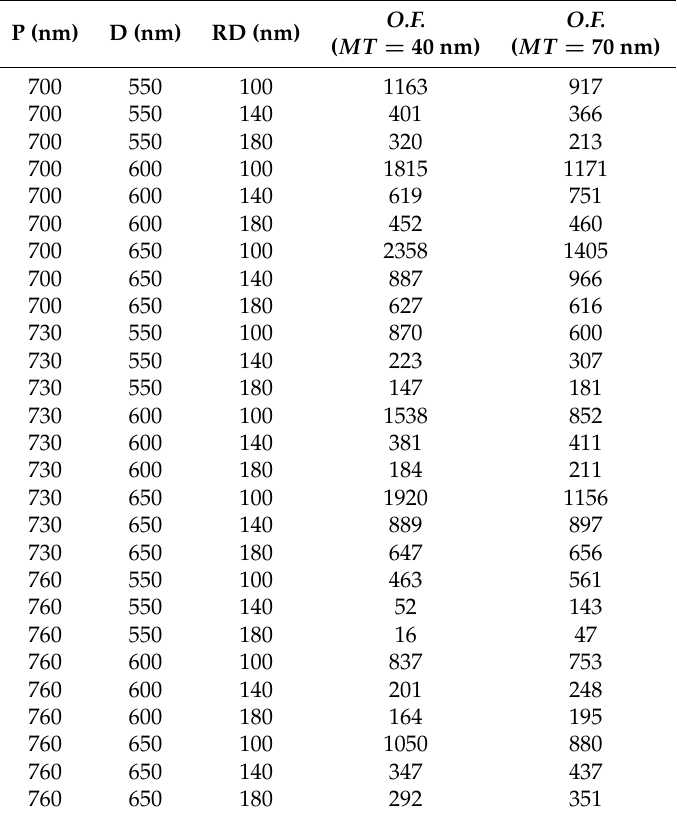
Figure 9. Extinction efficiency, Q ext , for a 300 nm diameter spherical gold nanoparticle. Table 2. Optimization factors for nanowell geometries imbedded with 300 nm spherical gold